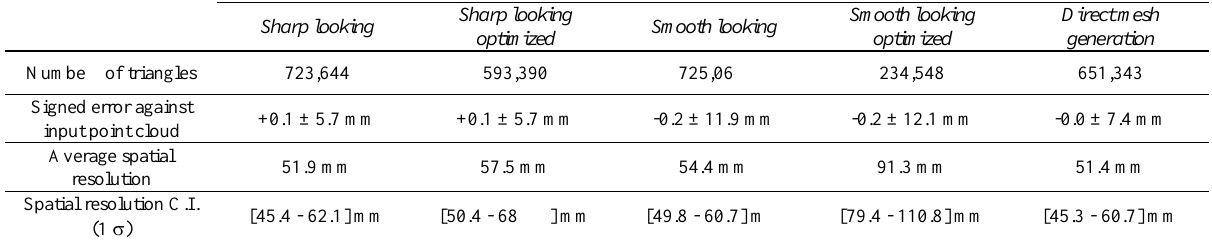
Table 6. Results of the simplification methods for a 5 cm target